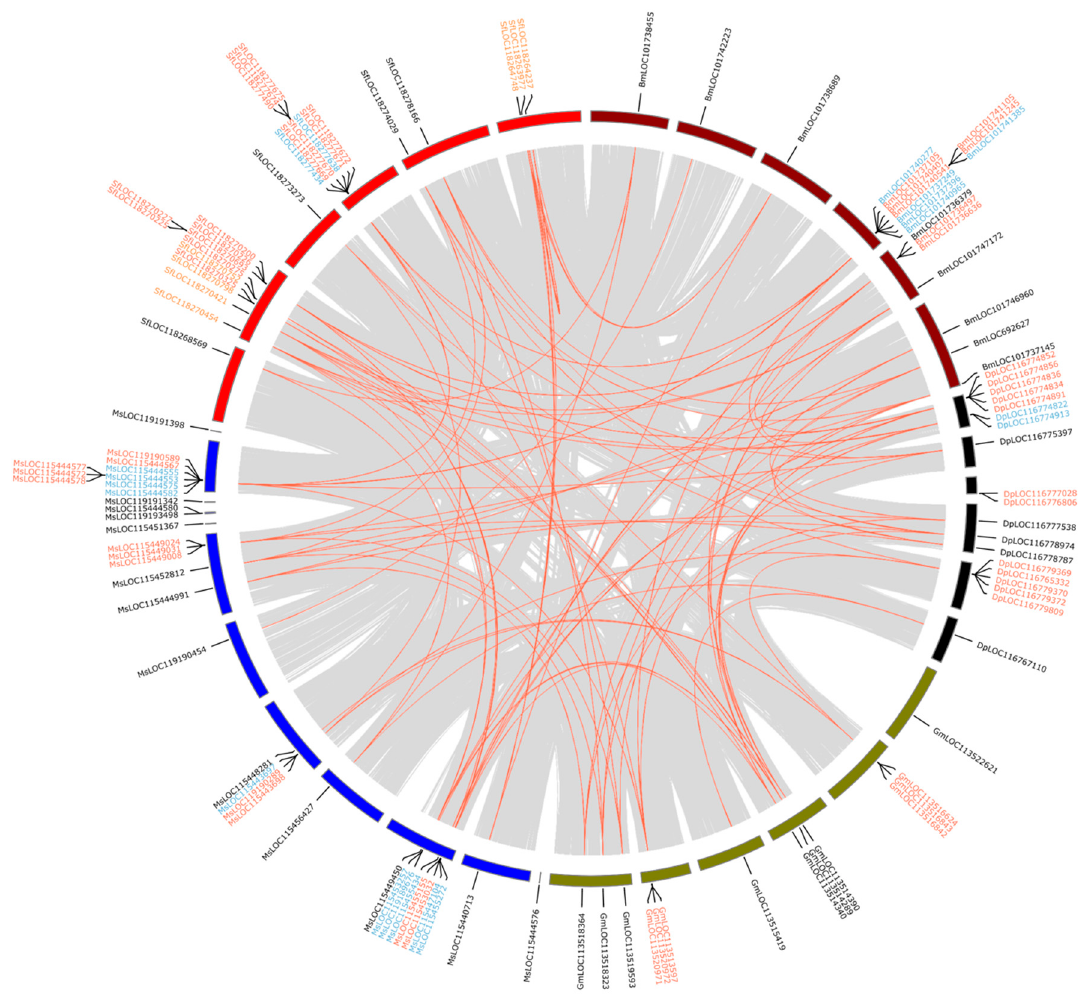
Figure 6. Chromosomal locations and duplications modes of identified GH1s in selected species of Lepidoptera. Gene names are presented with two-letter species abbreviations and gene ids; red, blue, black, and yellow gene names represent tandem duplications, proximal duplications, dispersed duplications, and segmental duplications, respectively. Different color of karyotype indicates different species and red lines link the GH1 genes from collinear blocks. Bm, Bombyx mori ; Dp, Danaus plexippus ; Gm, Galleria mellonella ; Ms, Manduca sexta ; Sf, Spodoptera frugiperda .